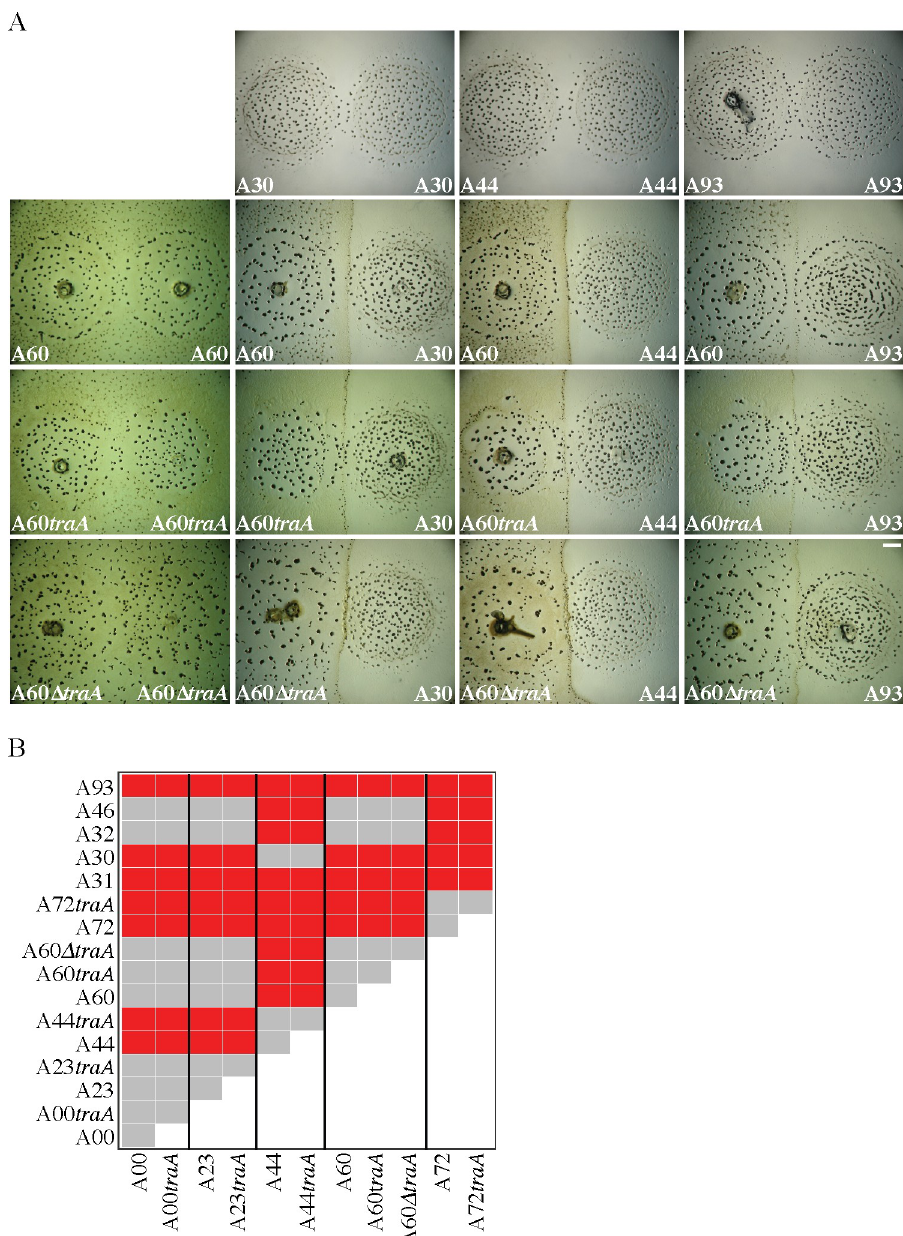
Fig 3. Disruption of traA does not alter CMI-occurrence patterns across pairings of traA- identical natural isolates. A. Examples of self-self colony-encounter phenotypes (left column and top row) and CMI phenotypes between distinct natural isolates and respective traA mutants (other images). Scale bar: 1 mm. B. All possible pairwise encounters between strains sharing the same traA allele for one of several alleles. (See also S2 Fig for results from other allele categories.) Red represents formation of visible CMI demarcation boundaries while grey represents the absence of such boundaries. In no case did disruption of traA (or deletion in the case of A60) eliminate a CMI boundary present between colonies of two natural isolates (or generate such a boundary not present between two isolates). The plasmid-integration and in-frame-deletion mutants of A60 exhibit CMIs with the same set of natural isolates as the parent